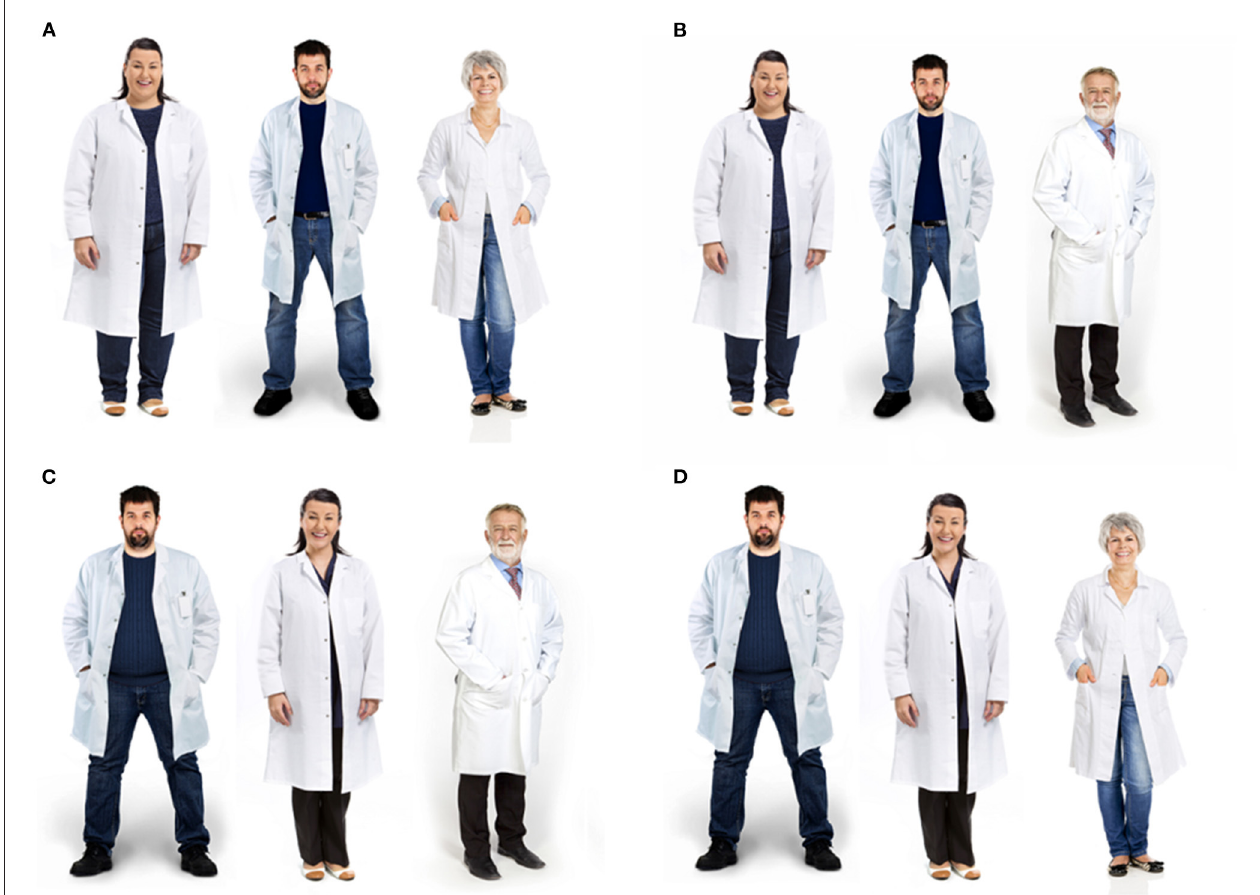
FIGURE 1 | Dietitians varying in weight, gender, and age (presented in different blocks). (A) Woman with obesity, man without obesity, older woman; (B) Woman with obesity, man without obesity, older man; (C) Man with obesity, woman without obesity, older man; (D) Man with obesity, woman without obesity, older woman.